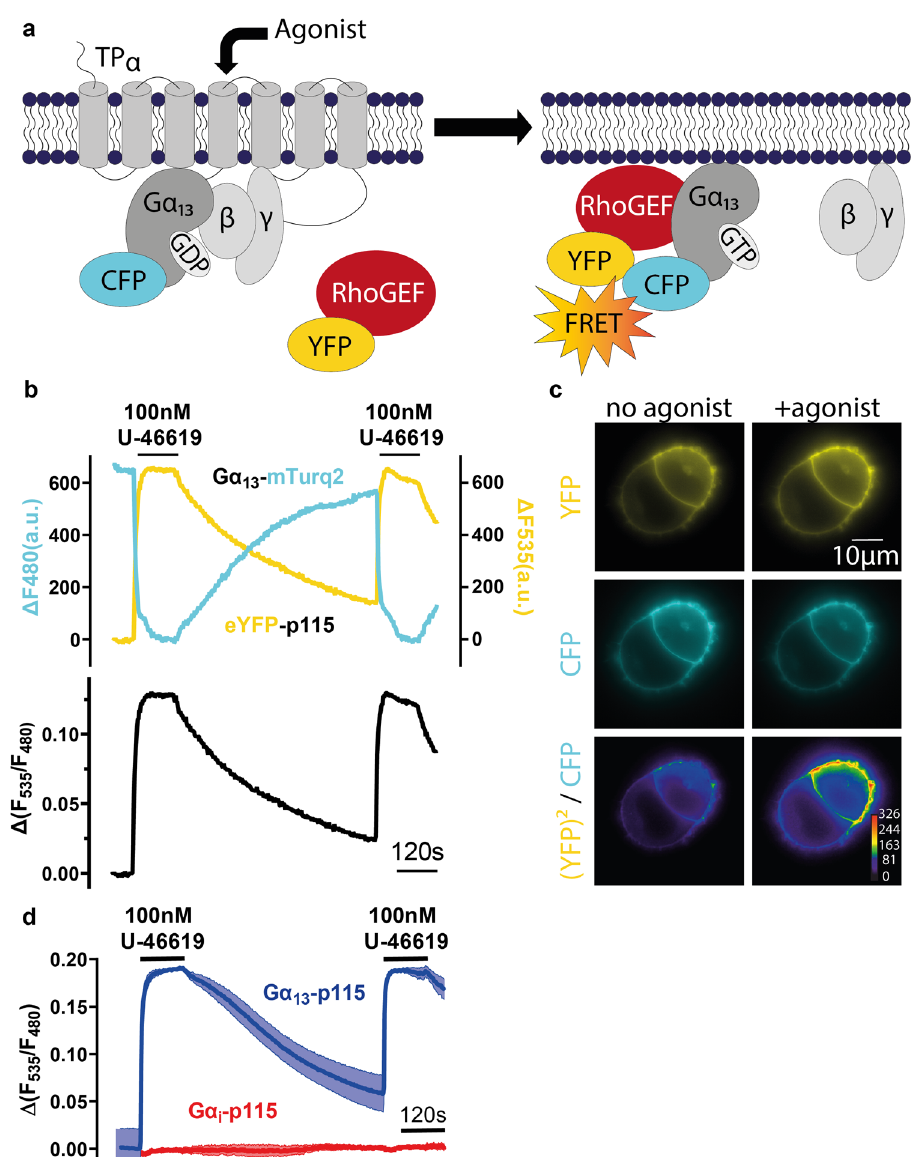
Fig. 1 Interaction of G α 13 and p115-RhoGEF visualized by FRET. a To measure the G α 13 -p115 FRET-interaction, G α 13 was tagged with mTurqoise2, while p115 was labeled N-terminally with YFP. Upon agonist application the activated GPCR (TP α ) activates G α 13 , which recruits p115-RhoGEF to the plasma membrane detectable by FRET. b Depicted is a representative single cell recording of FRET between G α 13 -mTurq2 and YFP-p115. Cells were excited at 425 nm and the emission was simultaneously detected at 480 nm (blue) and 535 nm (yellow). Switching the superfusion buffer to U-46619-containing buffer led to a TP α -mediated interaction of G α 13 -mTurq2 and YFP-p115 as re fl ected by an increase of the F 535 /F 480 emission ratio. c FRET between G α 13 - mTurq2 and YFP-p115 can be observed through agonist application. Multiplication of the YFP image with itself divided by the respective CFP (cyan fl uorescent protein) image visualizes the F 2 /CFP panel 535 /F 480 emission ratio change (see methods section for image processing). The colors in the (YFP) represent fl uorescence intensity according to the provided scale. d Mean±SEM trace of the assay described in A (G α 13 -p115 interaction). An emission ratio change can be observed by applying agonist [blue, n = 8]. On the other hand, transfection of G α i -mTurq2 instead of G α 13 -mTurq2 did not lead to an emission ratio change [red, n = 7], validating the speci fi city of the